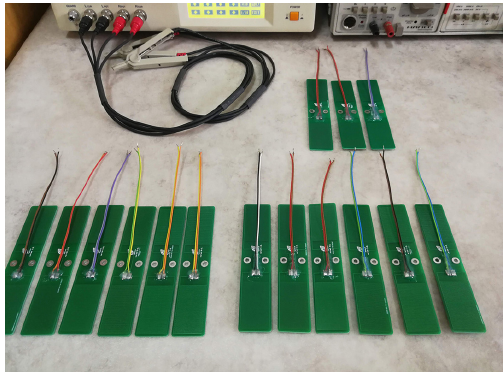
Figure 3. Sensors investigated in this work. 12 of them are fabricated on standard 1.6 mm thickness PCB with S and W varying from 5 to 20 MILs and 3 of them are fabricated on 0.8 mm thickness PCB with fixed aspect ratios W/S = 5/5, 10/5 and